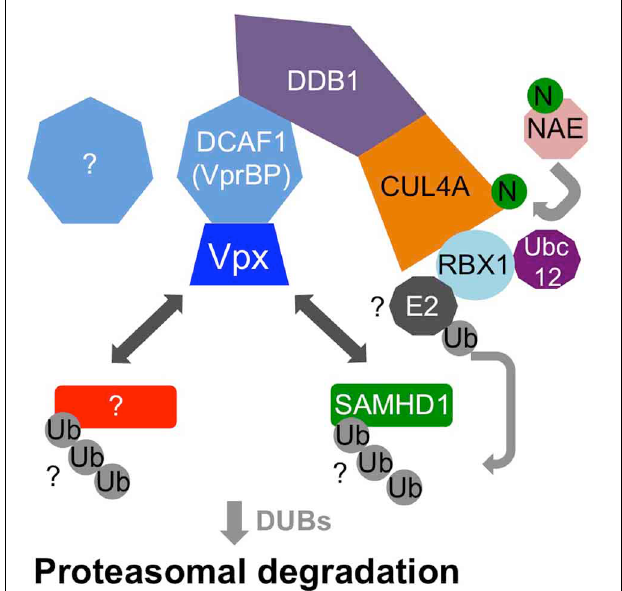
FIGURE 2 | Model of DCAF1-DDB1-CUL4A recruitment by Vpx. Vpx hijacks the DDB1-CUL4A-RBX1 E3 ubiquitin ligase complex